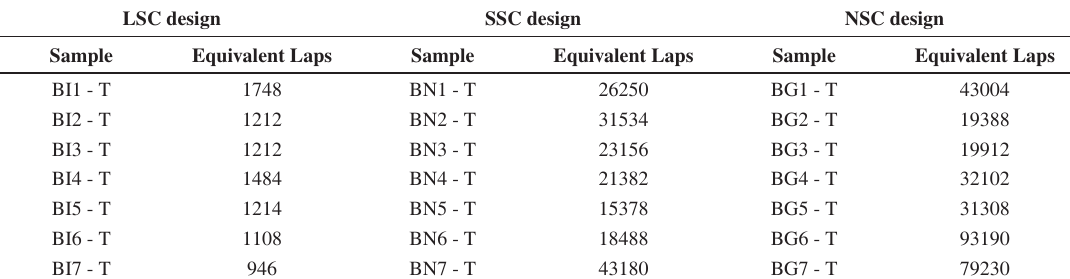
Table 3. Experimental life results for the designs materials specimens as equivalent laps.